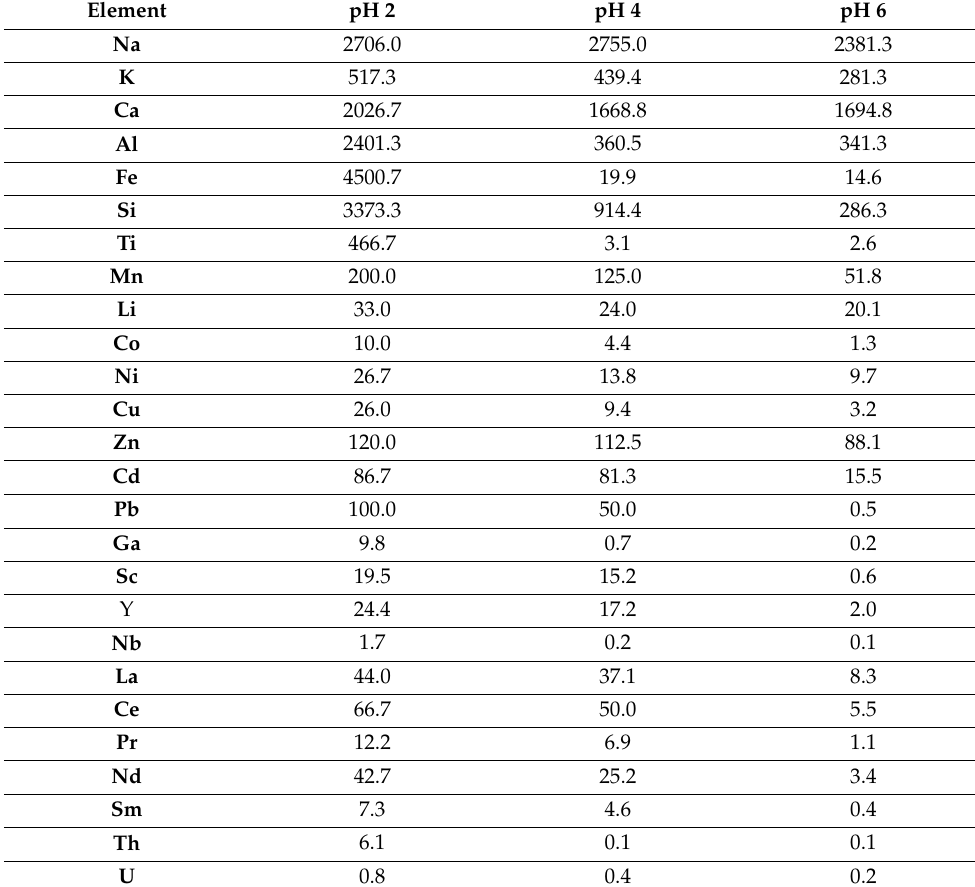
Figure 4. Effect of pH at a temperature of 80 ◦ C, leaching time of 60 min, L/S ratio of 10:1, and MgSO 4 concentration of 24 g L − 1 on: ( a ) the extraction of major elements; ( b ) the extraction of minor elements. Table 4. Selected elements concentration in the leaching solutions (mg L − 1 ) obtained at pH values of 2, 4, and 6; temperature of 80 ◦ C; leaching time of 60 min; L/S ratio of 10:1; and MgSO 4 concentration of 24 g L − 1